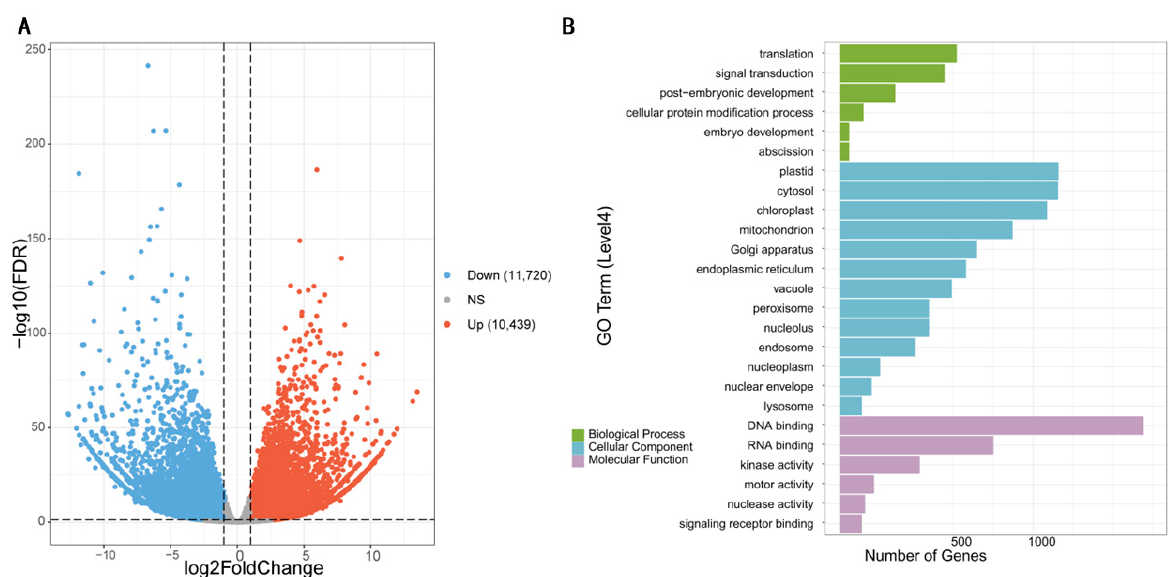
Figure 4. Identification and GO enrichment analysis of differentially expressed genes among materials with extreme hemicellulose content in rapeseed stalk. ( A ) Volcano map of all gene-expression differences among materials with extreme hemicellulose content in rapeseed stalk. The blue dot on the left is down-regulated genes, and the red dot on the right is up-regulated genes. ( B ) GO enrichment of differentially expressed genes.